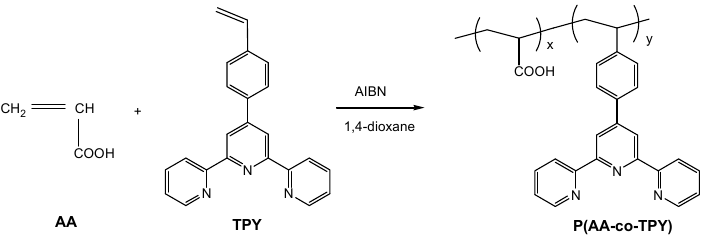
Scheme 2. Synthesis of the targeted polymer P(AA-co-TPY).